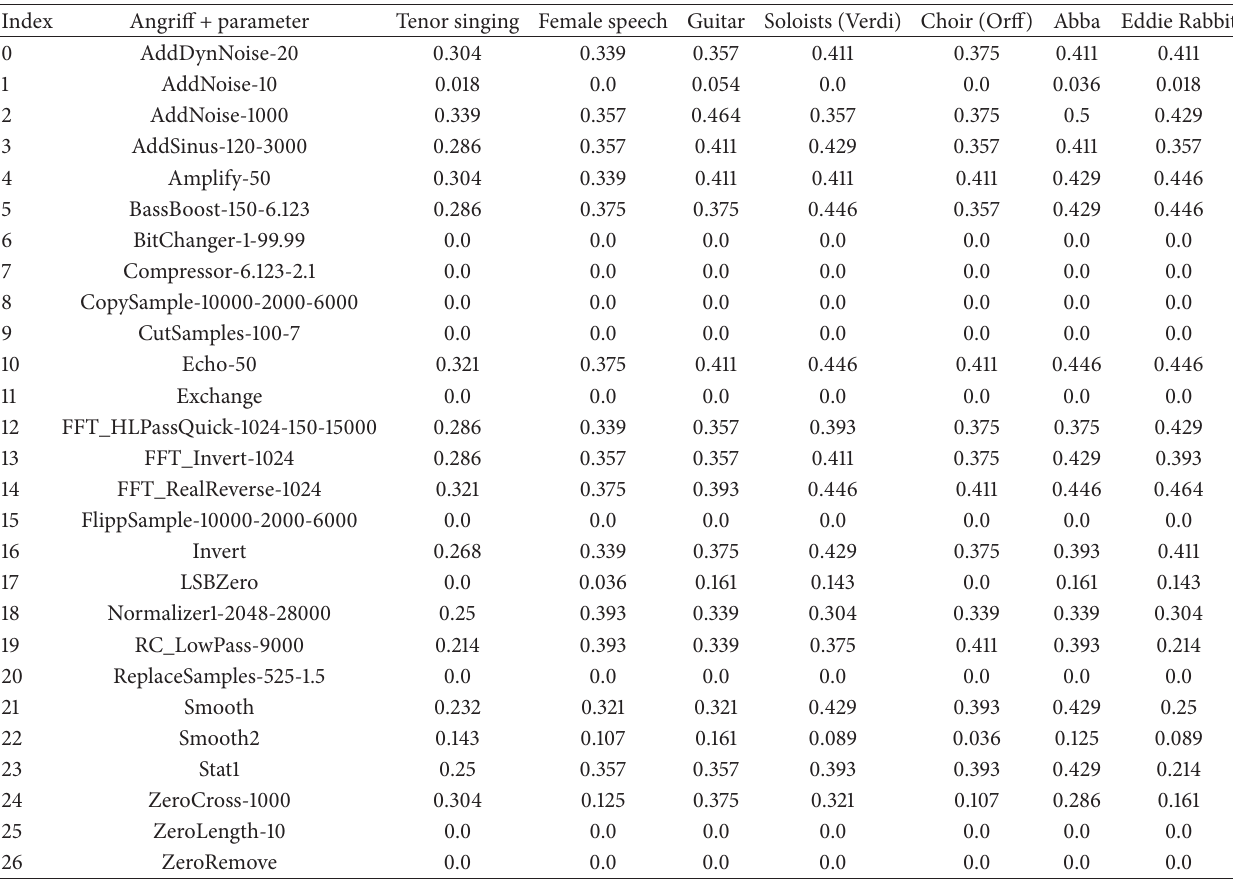
Table 2: Bit error rates of extracted 56 bit watermarks after various StirMark attacks on seven example audio files. Parameters used are